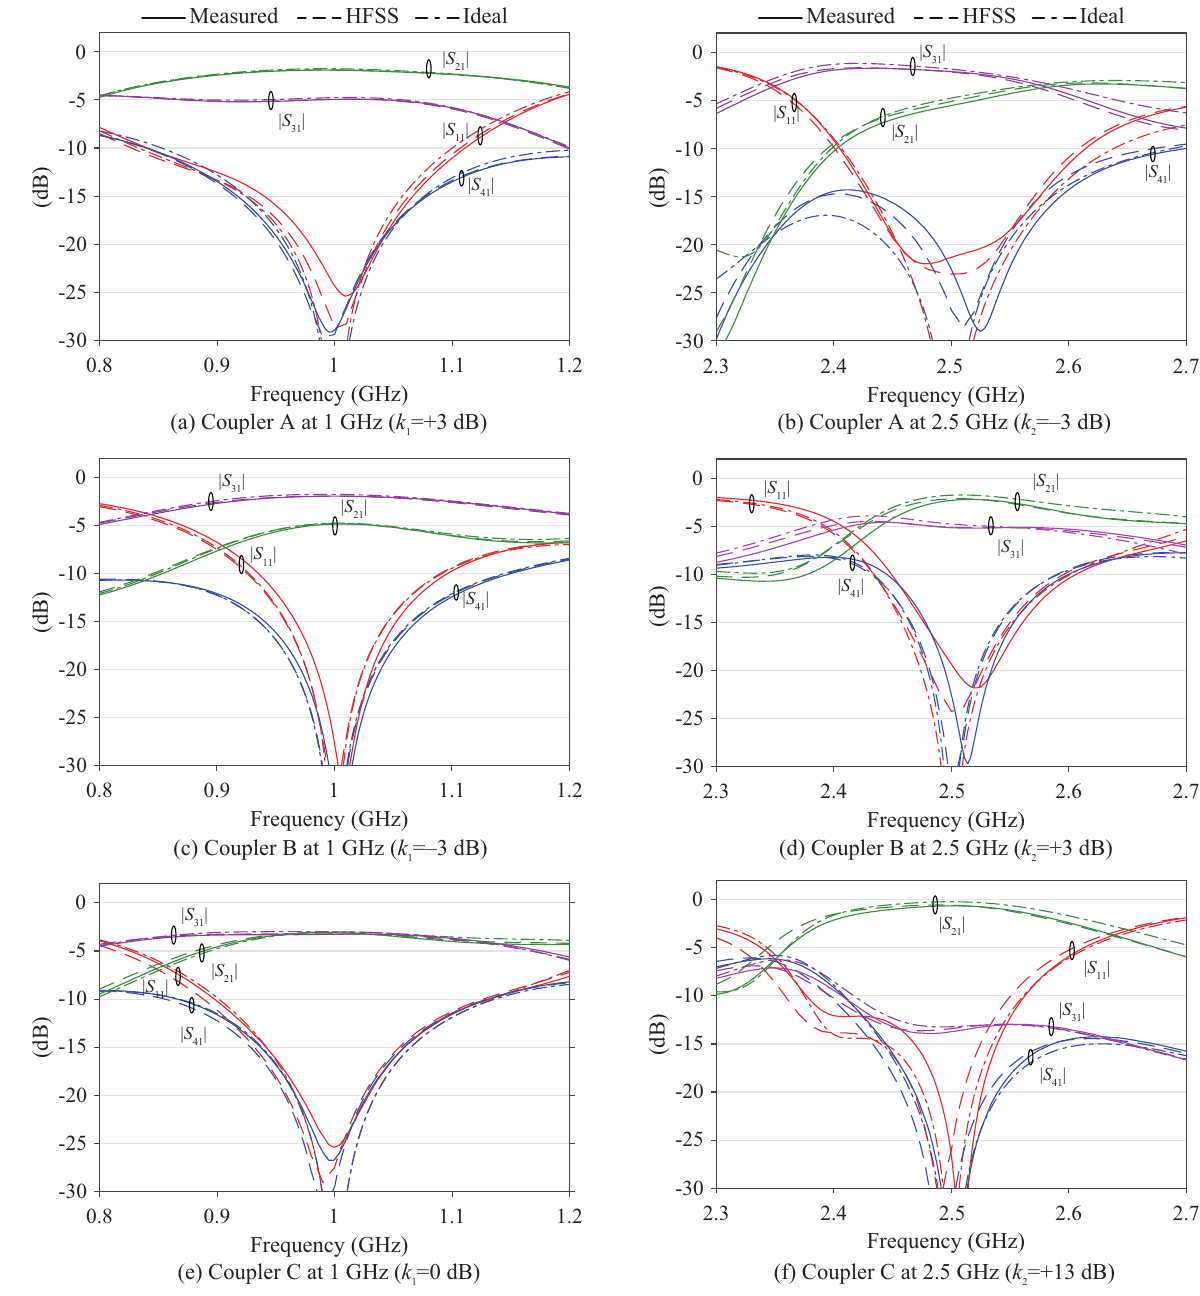
Figure 7. Zoom-in version of measured, full-wave, and ideal circuit simulated